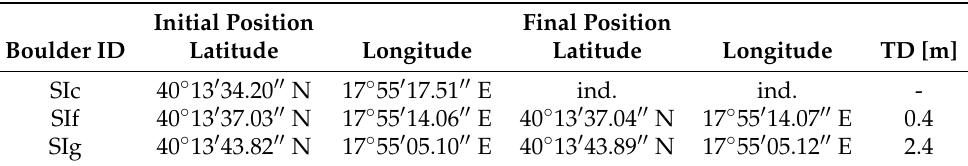
Figure A1. Torre Sant’Isidoro coast. Below the boulder SIf, its socket was recognized during the field survey (from [10], modified). By the June 2020 satellite image, the other boulder (highlighted in red dashed line) was not identified despite its socket (very evident in the photo). Note that the field survey was made one month after the date of the last GE image. Table A3. Initial and final geographical coordinates of the displaced boulders at the Torre Sant’Isidoro coast; ind.,